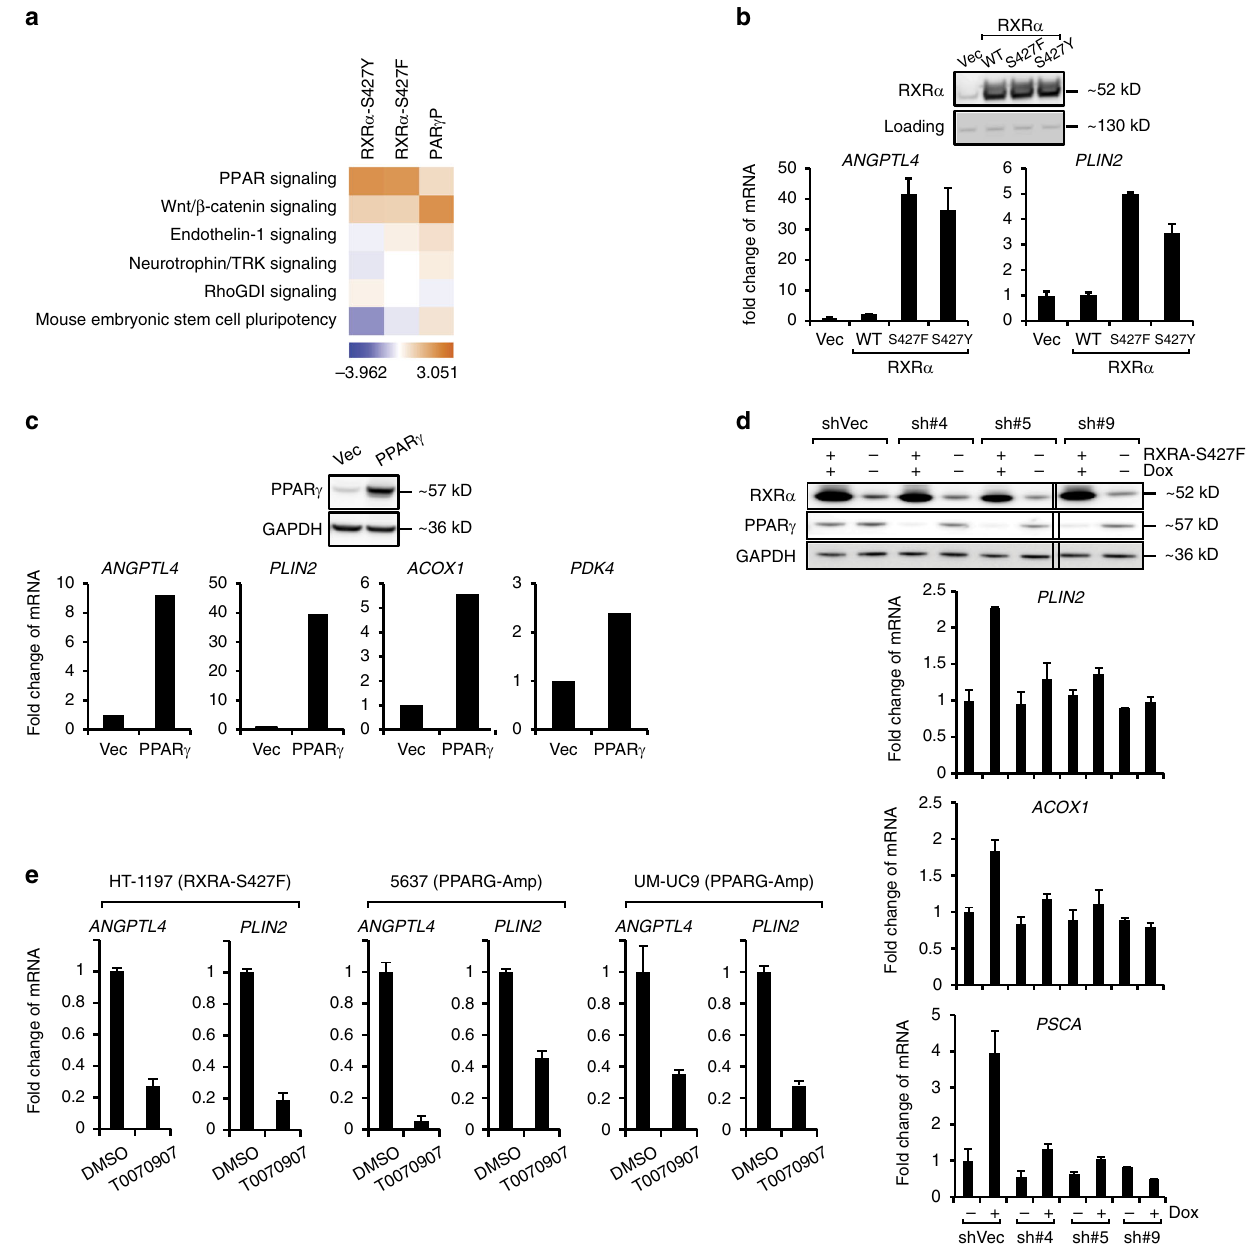
Fig. 3 RXR α S427F/Y functionally promotes ligand-independent PPAR γ signaling in human bladder cancer lines. a Heat map representing pathways activated/suppressed in RXR α S427Y , RXR α S427F and PPAR γ overexpressing lines relative to their respective controls. Orange represents pathway activation and blue represents pathway suppression. The analysis was based on three biological replicates. b Upper , western blot of RXR α con fi rming overexpression of RXR α WT (WT), RXR α S427F (S427F) and RXR α S427Y (S427Y) in T24 cells relative to control (Vec). Lower , RT-qPCR analysis of ANGPTL4 and PLIN2 in various engineered lines. c Upper , western blot con fi rming overexpression of PPAR γ in T24 line relative to control (Vec). Lower , RT-qPCR analysis of ANGPTL4 , PLIN2 , ACOX1 and PDK4 in engineered lines. d Upper , western blot of RXR α and PPAR γ in SV-HUC line engineered to inducibly overexpress RXR α S427F and knockdown PPAR γ by multiple shRNAs (sh#4, 5 and 9) upon doxycycline ( DOX ) treatment. Lower , RT-qPCR analysis of PLIN2 , ACOX1 and PSCA in various SV-HUC-1 engineered lines. +/ − represents presence or absence of DOX treatment respectively. e RT-qPCR analysis of ANGPTL4 and PLIN2 in HT-1197 (carrying endogenous RXRA S427F ), 5637 and UM-UC9 (PPARG ampli fi ed) lines treated with DMSO or T0070907 for 24 h. All